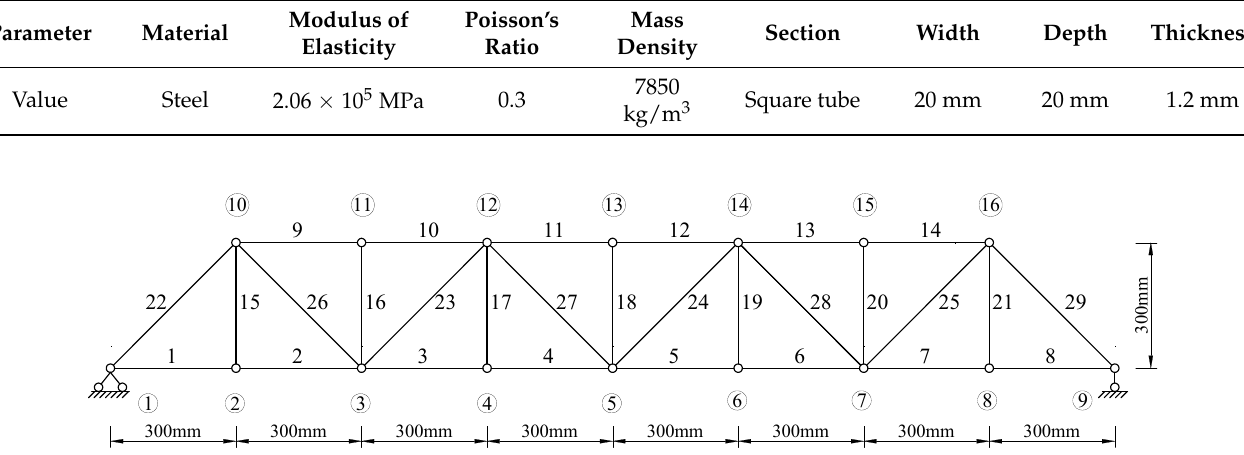
Figure 8. Finite element model of the steel truss structure.